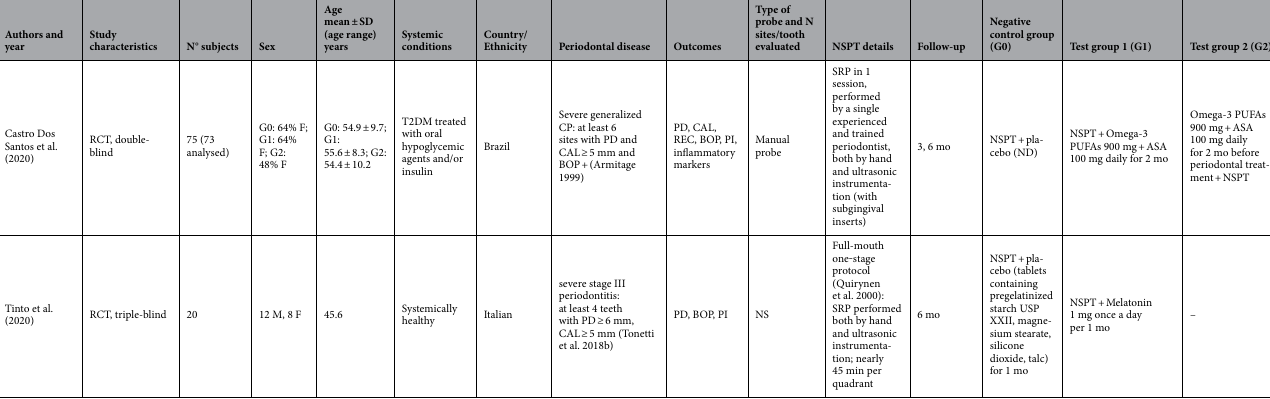
Table 1. Main characteristics of the included studies. Abbreviations and references used in this table are reported in Appendix